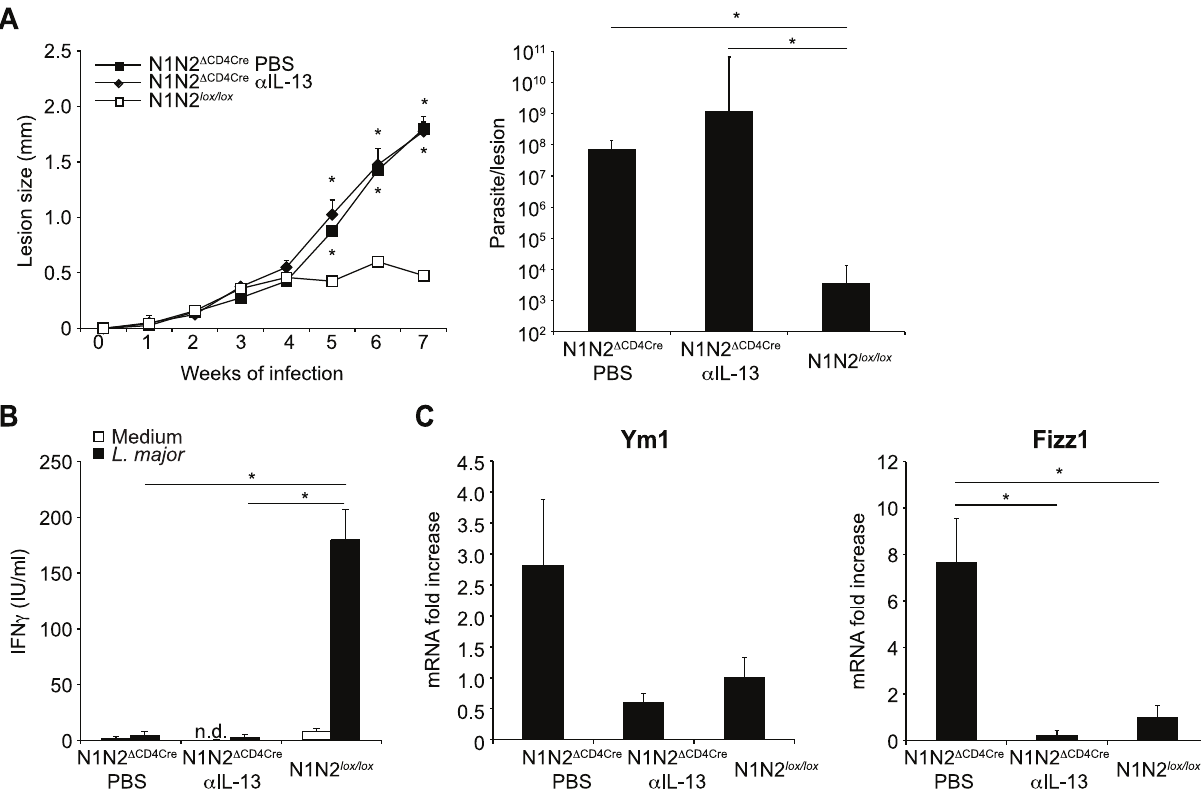
Figure 4. Treatment with anti-IL-13 does not restore resistance of N1N2 D CD4Cre mice to L.major . (A) N1N2 D CD4Cre and control N1N2 lox/lox mice were infected s.c. with 3 6 10 6 L. major promastigotes. At day 21 of infection, N1N2 D CD4Cre mice were treated i.p. with either anti-IL-13 mAb or PBS as control. Treatment was repeated once a week until the end of the experiment, and lesion development was monitored. Group means of lesion size 6 SEM (n $ 3 mice per group) are represented. The parasite load at the site of infection was assessed by LDA 47 days post infection. Group means of parasite number are given 6 SEM (n $ 3 mice per group). (B) CD4 + T cells were isolated by MACS from dLN of L. major -infected mice 47 days post infection and restimulated with or without UV-treated L. major in presence of irradiated syngenic splenocytes. IFN c level was measured in supernatant after 72 h of stimulation. Data are expressed as the group mean 6 SEM of cytokine measurement of n $ 3 draining lymph nodes (C) Ym1 and Fizz1 mRNA expression was analyzed in dLN cells by quantitative real-time PCR and normalized to HPRT mRNA expression. Results are represented as fold-increase in mRNA levels relative to levels measured in control mice 6 SEM (n $ 3 mice per group). Data are representative of three independent experiments. Similar results were obtained when anti-IL-13 was administrated 7 days post infection (data not shown). * p-value , 0.05 versus control mice.